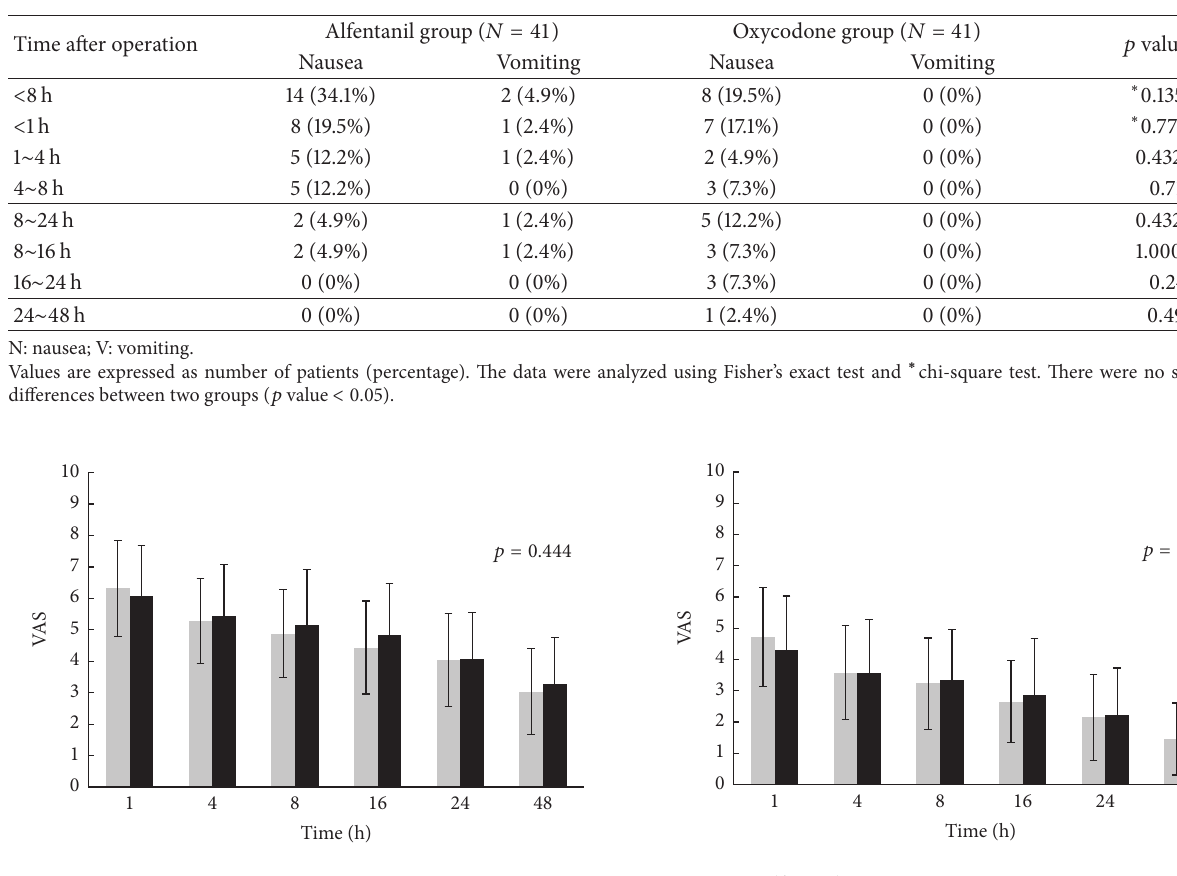
Table 2: Incidence rate of postoperative nausea and vomiting.